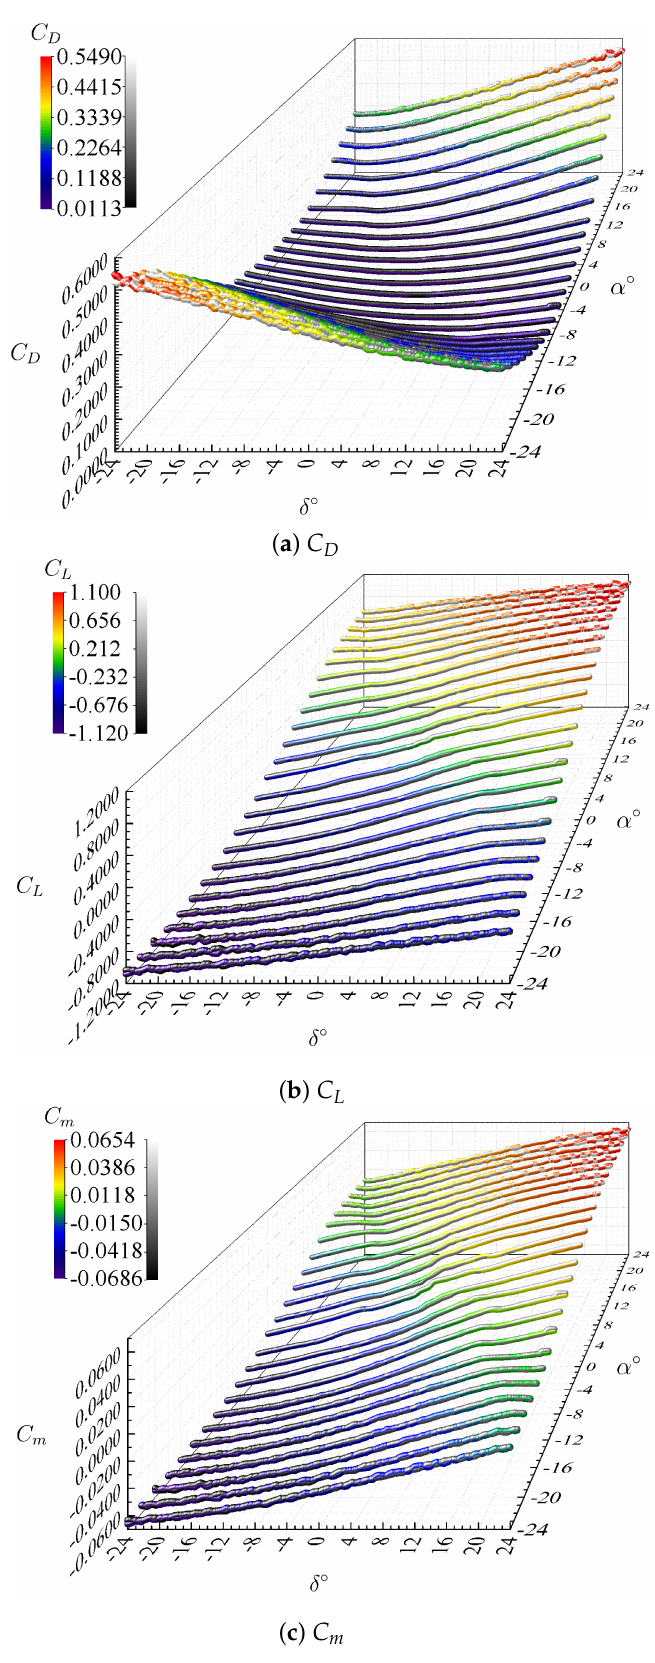
Figure 9. The aerodynamic data acquired by changing α and δ